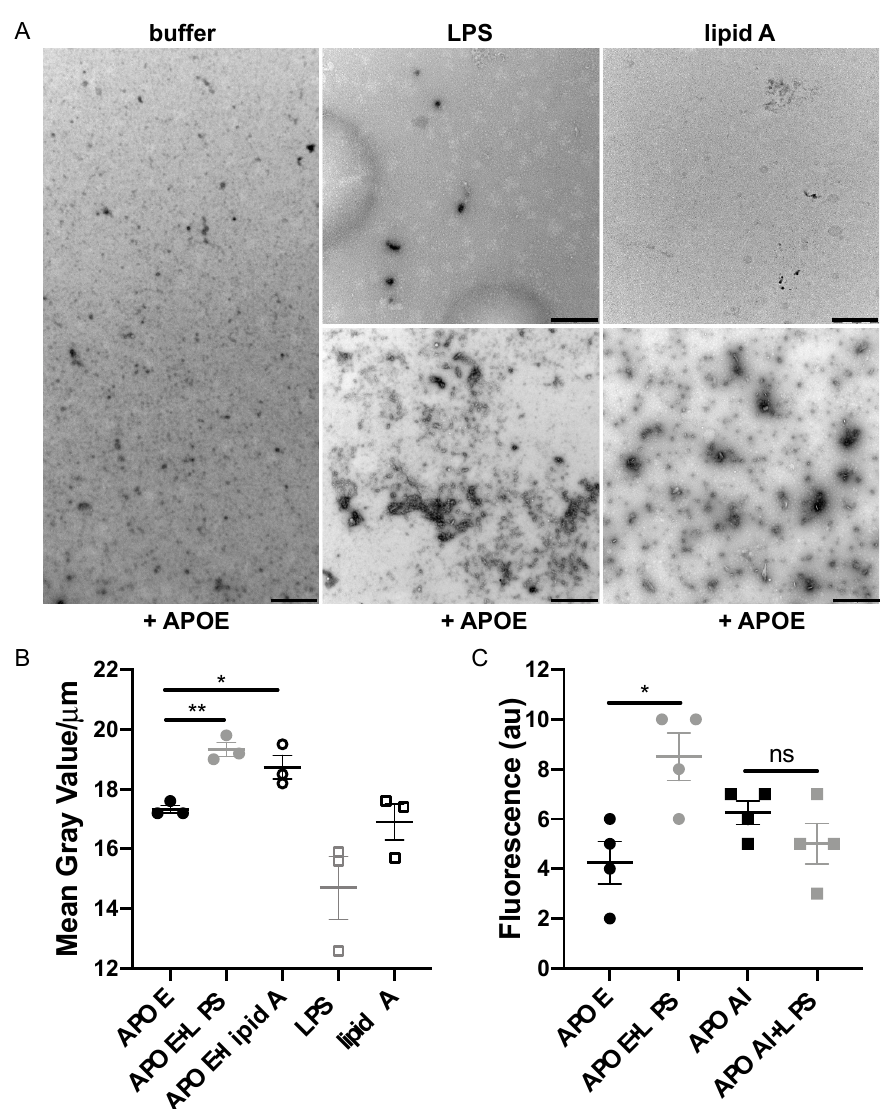
Figure 4. Detection of macromolecular complexes of APOE and bacterial products. ( A ) APOE (2 µ M) was incubated with 100 µ g/mL LPS or with lipid A from E. coli for 30 min at 37 ◦ C. At the end of incubation, the macromolecular complexes were visualized by TEM. One representative image for each condition from three independent experiments is shown ( n = 3). Scale bar represents 1 µ m. ( B ) Analysis of the complexes of APOE and ligands following TEM. Quantification was performed using ImageJ 1.52k after all the images were converted to 8-bit, and the threshold was adjusted. The complexes of APOE and ligands are expressed as the mean of gray value/ µ m ± SEM. In the graph, each point represents at least ten pictures per each experiment ( n = 3). Statistical analysis was performed using a one-way ANOVA with Dunnett’s multiple comparison tests, * = p ≤ 0.05 and ** = p ≤ 0.01. ( C ) ThT assay demonstrates aggregation of APOE in the presence of LPS from E. coli (n = 4). Statistical analysis was performed using a one-way ANOVA with Dunnett’s multiple comparison tests, * = p ≤ 0.05 and ns = not significant. Black dot = APOE, gray dot = APOE+LPS, empty circle = APOE+lipid A, empty gray square = LPS, empty black square = lipid A, black square = APOAI and gray square = APOAI+LPS.